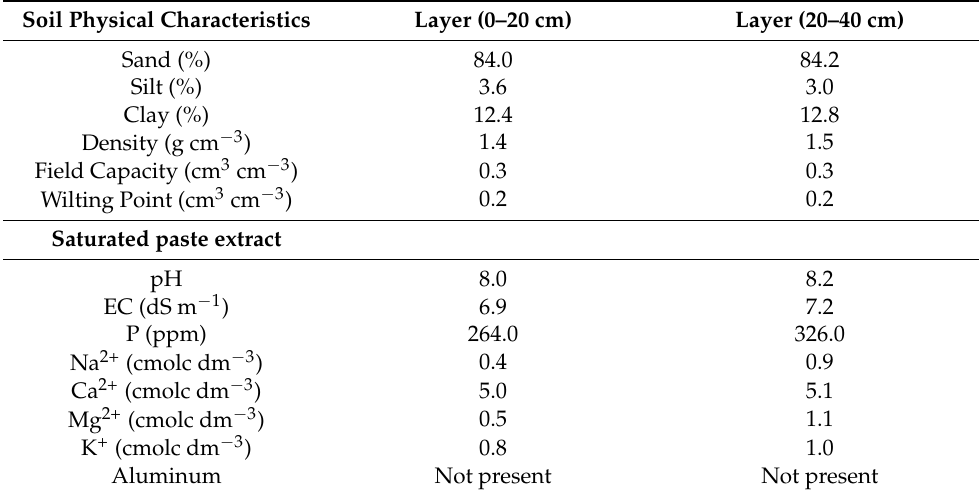
Figure 1. Location of the Ipojuca River catchment ( a ), sewage treatment station (STS), showing the area cultivated with forage sorghum ( b ), and agroclimatological information of the cultivation period over the three conducted cycles ( c ). Table 1. Soil physical-chemical characteristics at the experimental area cultivated with forage sorghum,